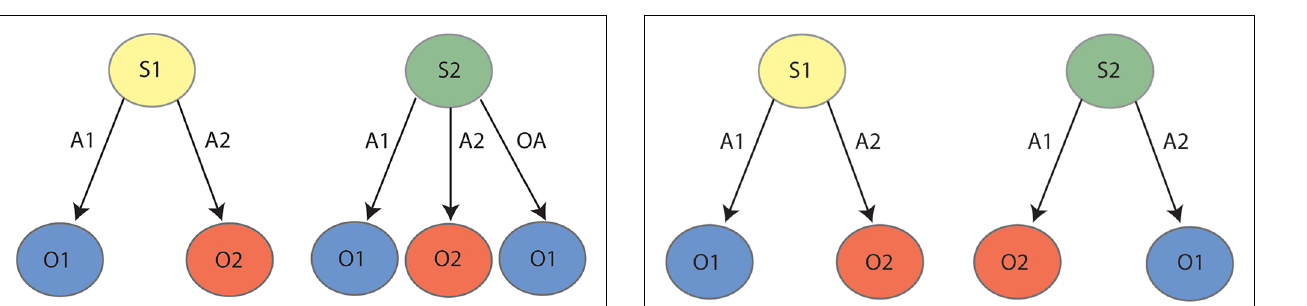
FIGURE 2 | State-space representation for outcome reversal: during the initial phase (left panel) the animal learns that action 1 (A1) earns outcome 1 (O1) and action 2 (A2) earns outcome 2 (O2). During reversal (right panel), the animal learns the reverse contingencies: A1–O2 and A2–O1. It is posited that the animal partitions the initial learning contingencies (A1–O1, A2–O2) and the reversed contingencies (A1–O2, A2–O1) into two states, state 1 (S1) and state 2 (S2),